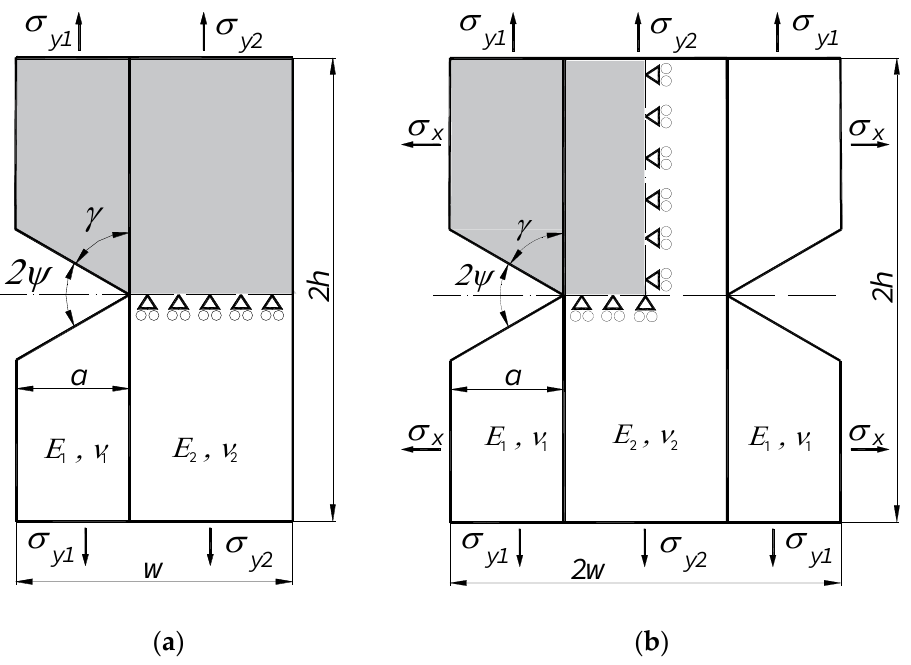
Figure 3. Geometry and method of fixing and loading specimens: ( a ) with a single edge-notched plate, and ( b ) with a double edge-notched plate.